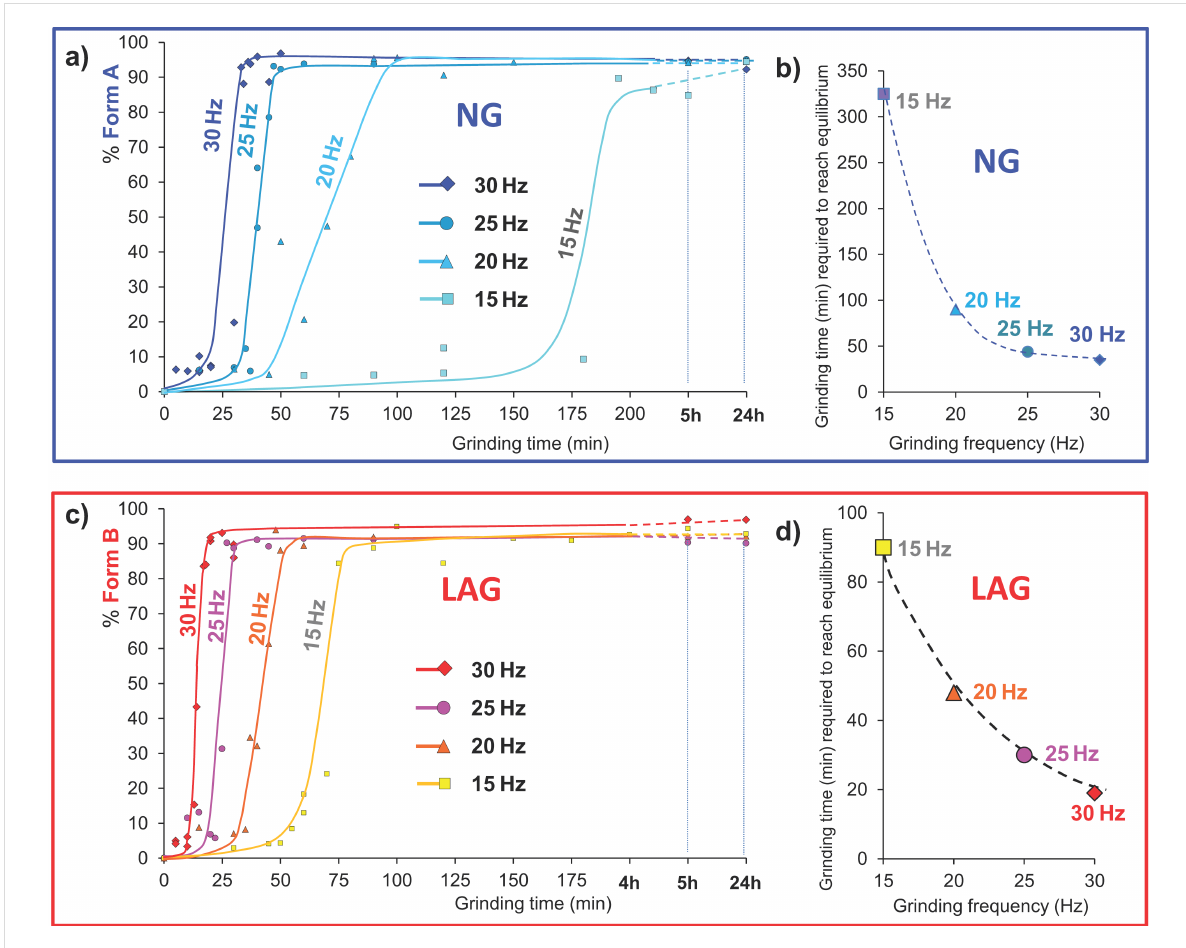
Figure 1: Solid-state studies reacting 1-1 and 2-2 in an equimolar ratio in the presence of DBU as catalyst to give the heterodimer 1-2 . (a) And (c) show the dependence of reaction progress (obtained by the Rietveld quantitative phase analysis) on milling frequency under ball-mill NG and LAG conditions (with 50 μ L of MeCN), respectively. No fitting was performed, and the kinetic curves are only a guide to the eye. Each time point in these kinetic plots corresponds to a separate grinding